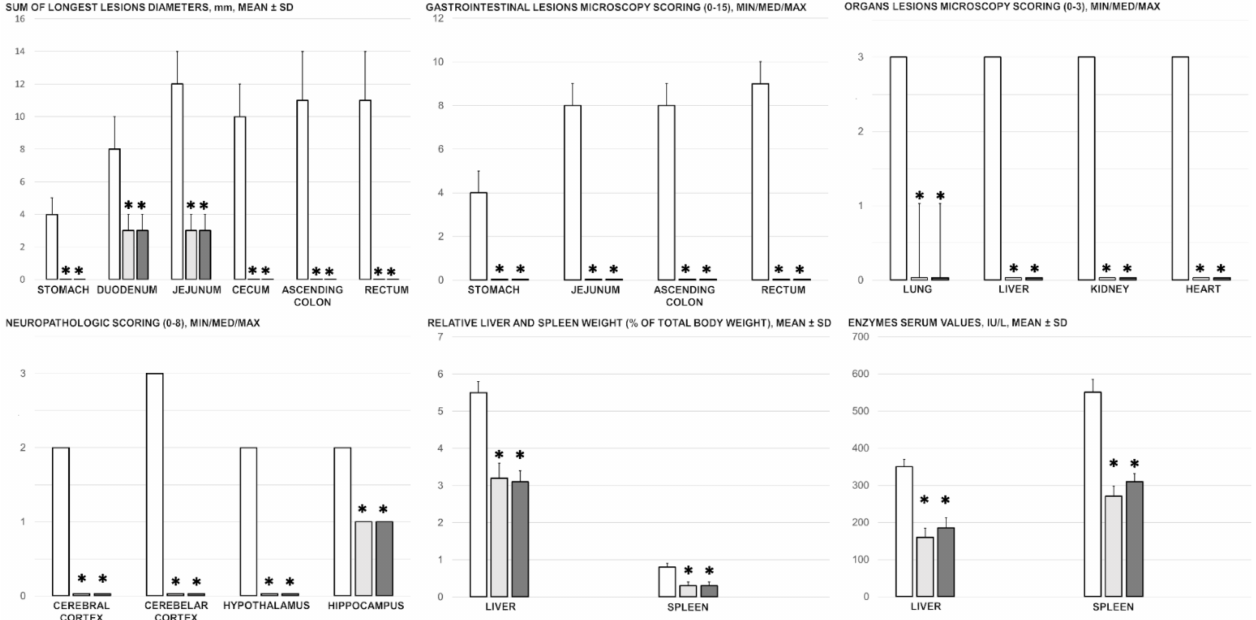
Figure 3. Gross gastrointestinal lesions presentation (sum of the longest lesions diameters, mm, mean ± SD), gastrointestinal lesions microscopy (scoring (0–15, Min/Med/Max), organs (lung, liver, kidney, and heart) lesions microscopy (scoring (0–3, Min/Med/Max), neuropathologic scoring (cerebral cortex, cerebellar cortex, hypothalamus, hippocampus, 0–8), enzymes serum values (IU/L, mean ± SD), liver and spleen relative weight (% of total body weight, mean ± SD) at 30 min ligation-time following medication (BPC 157 10 µ g/kg (light gray bars), 10 ng/kg (dark gray bars); saline 5 mL/kg (white bars) given intraperitoneally. Six rats/group/interval. * p < 0.05, at least vs.